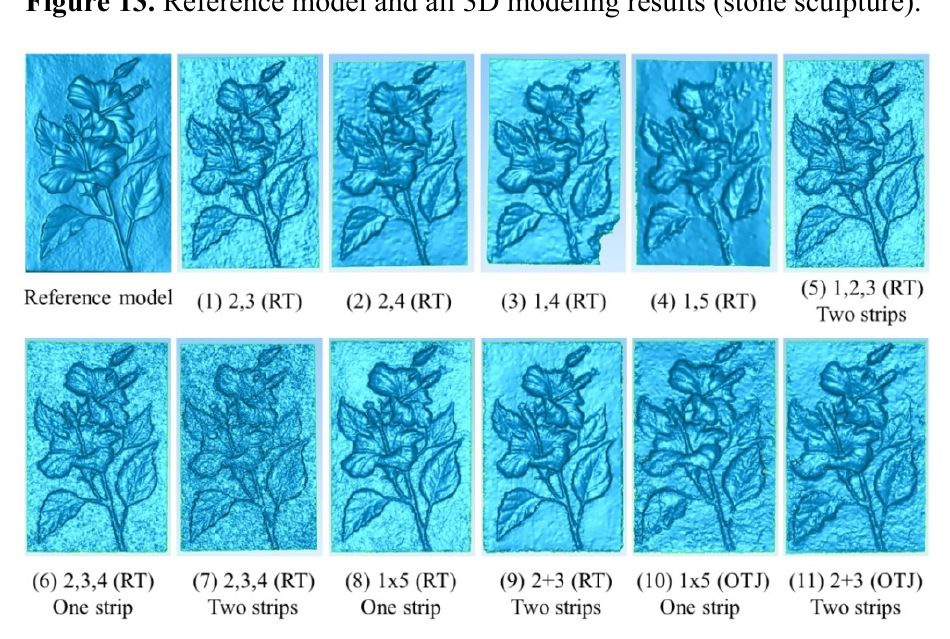
Figure 13. Reference model and all 3D modeling results (stone